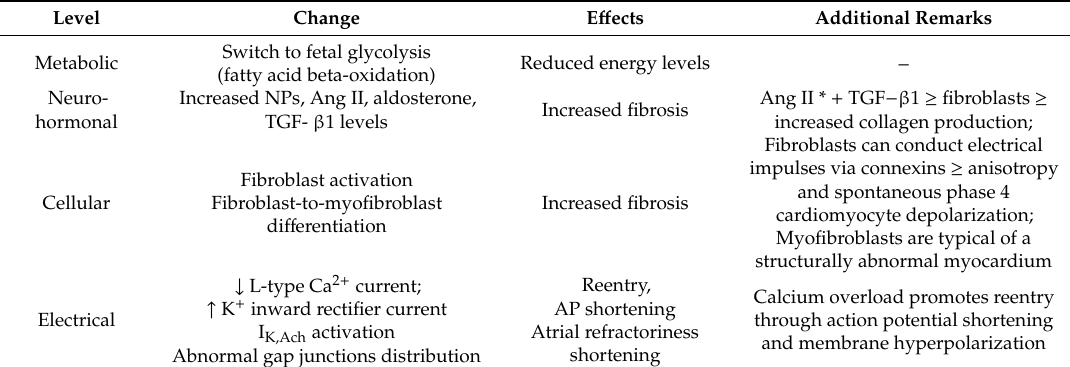
Table 1. Cellular (mal) adaptive changes in left atrial